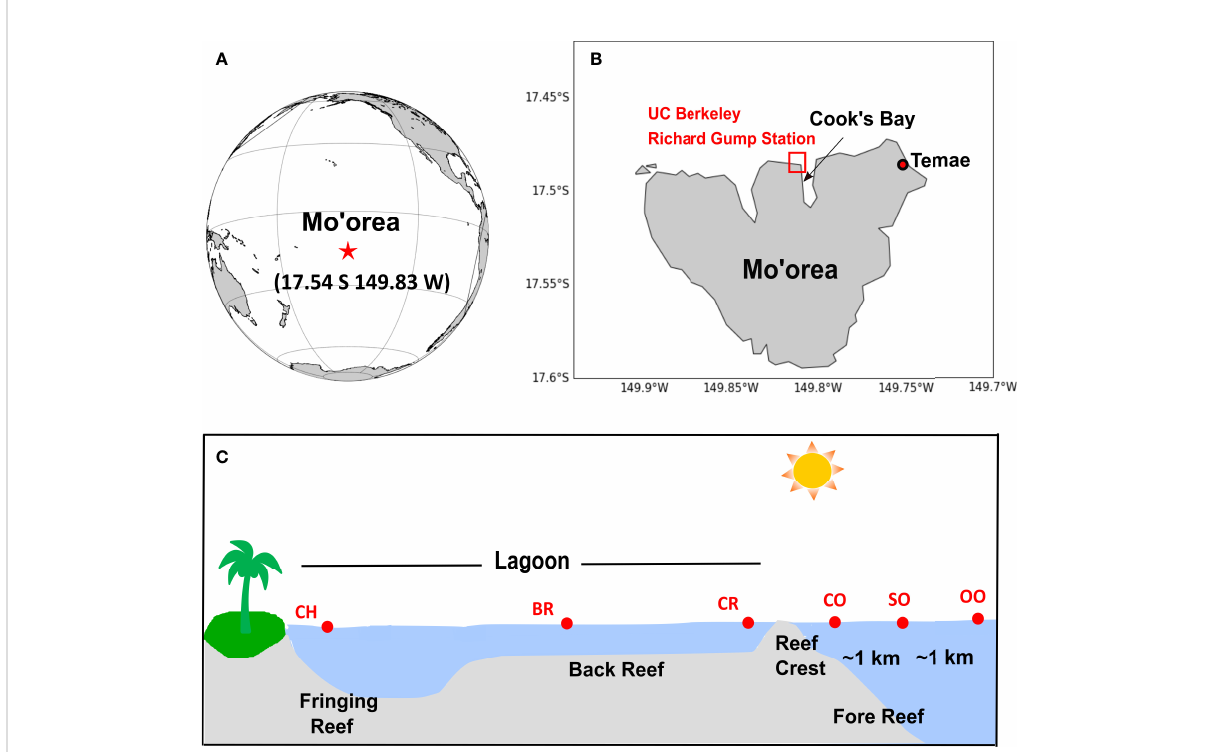
FIGURE 1 Locations of (A) the island of Mo ’ orea, in the South Paci fi c Ocean, (B) the Temae Park coral reef, and the UC Berkeley ’ s Richard Gump Research Station and coral reef where most of the work reported here was conducted, and (C) schematic showing the Mo ’ orea coral reef and reef-ocean transect sampling stations: nearshore out fl ow channel (CH), back reef (BR), reef crest (reef side of the reef crest, CR), ocean crest (ocean side of the reef crest, CO, ~300 m away from station CR), shelf ocean (SO, ~1 km away from CO), and open ocean (OO, ~2 km away from CO). Note that distances between stations are not drawn to scale. Panel (C) was adapted with permission from Leichter et al.